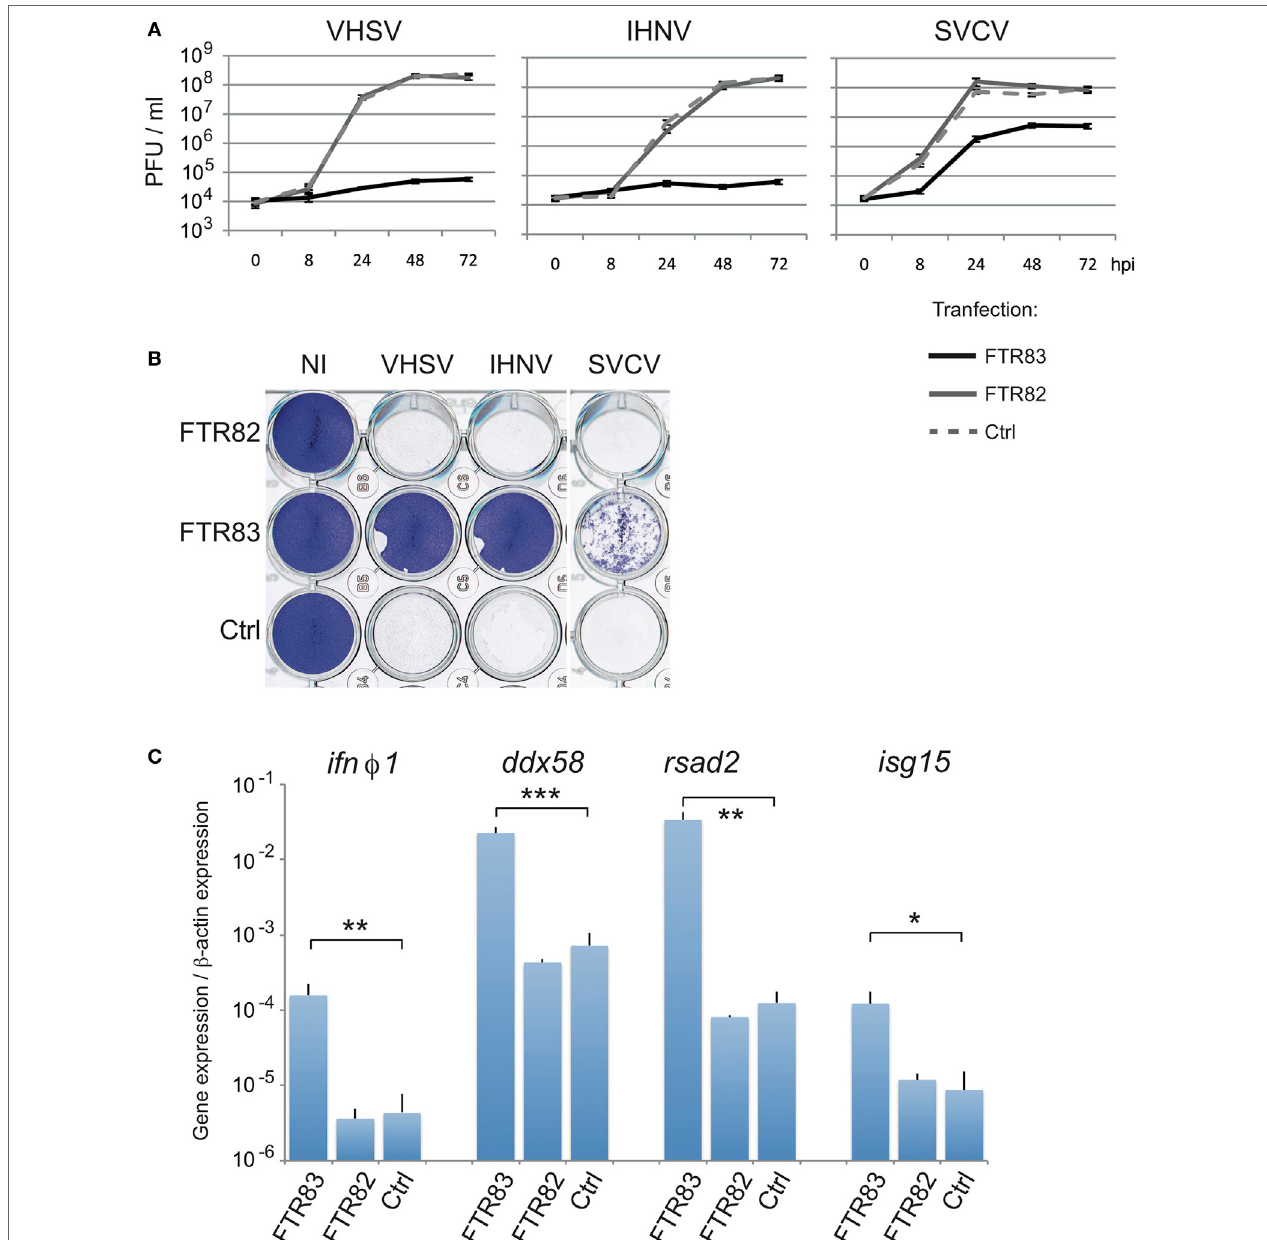
FigUre 3 | FTr83 overexpression inhibits viral infection . (a) Kinetic of viral growth measured by viral titration from 0 to 72 hpi in the supernatants of cells transfected with expression plasmids for ftr83 (black line) or ftr82 (gray line) or with empty vector as control (dotted line). Cells were infected at 72 hpt with IHNV, VSHV, or spring viremia of carp virus (SVCV) (MOI 1). The mean and SD of three independent experiments are presented. (B) Cytopathic effect of viral infections. Cells were infected 72 h post transfection at MOI1 and viral-induced cytopathic effect was assessed by crystal violet staining at 72 hpi. Non-infected cells are presented as a control (NI). (c) FTR83 triggers the IFN signaling pathway. Epithelioma papulosum cyprini cells were transfected with expression vectors for ftr82 , ftr83 or with empty plasmid (Ctrl) and analyzed 72 h post transfection for modulation of genes of the IFN pathway: ifn ϕ 1 , ddx58 , rsad2 , isg15 . RTQPCR results were normalized on the β -actin expression: measured ratio of cDNA of interest/ β -actin cDNA is shown. Mean and SD are shown, for three independent experiments; stars indicate significant differences using Student’s t -test (*** p < 0.001, ** p < 0.01, *: p <